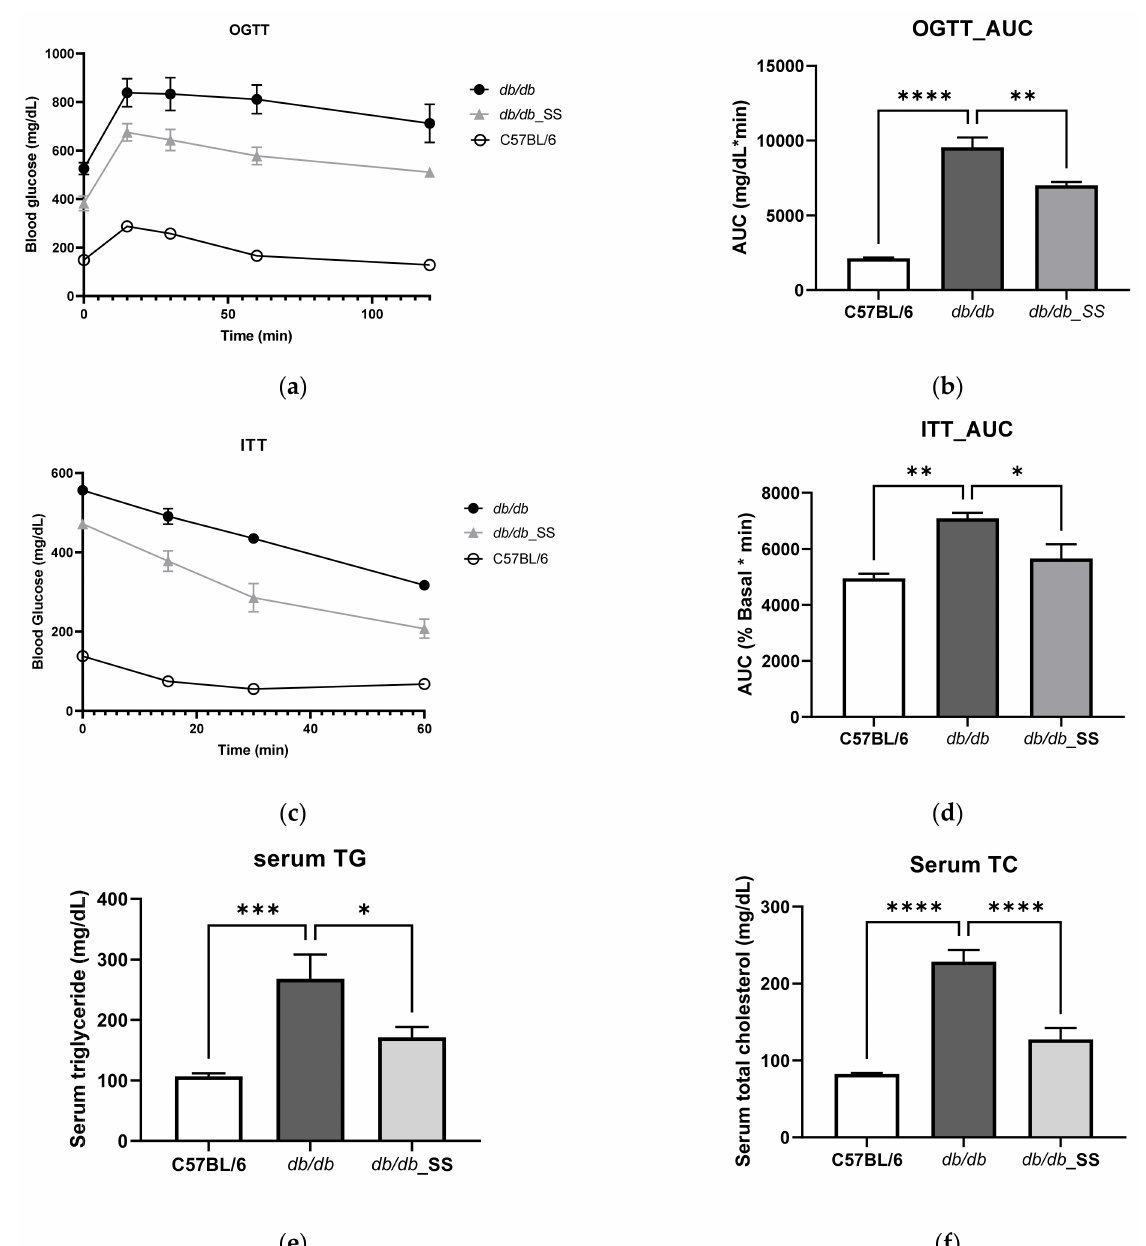
Figure 5. The effect of stevioside on the oral glucose tolerance test (OGTT), insulin tolerance test (ITT), and serum in db/db mice. ( a ) OGTT ( b ) OGTT_ area under the curve (AUC) ( c ) ITT ( d ) ITT_AUC ( e ) Serum triglycerides ( f ) Serum total cholesterol. C57BL/6; negative control group that received saline, db/db ; control group that received saline, db/db _SS; control group that received 40 mg/kg of stevioside. All data are presented as mean ± SD, and tests were performed in three independent experiments. * p < 0.05, ** p < 0.01, *** p < 0.001 and **** p <